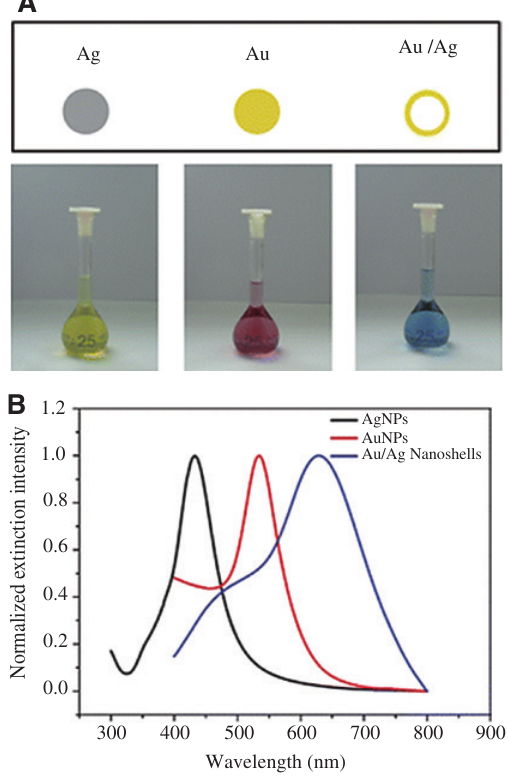
Figure 1: Photographs (A) and extinction spectra (B) of various 60-nm metal nanoparticles (AgNPs, AuNPs, and Au/Ag nanoshells) in water. LSPR peaks are observed at 430 nm, 540 nm, and 630 nm, respectively. Reprinted with permission from [139]. Copyright 2013 Royal Society of